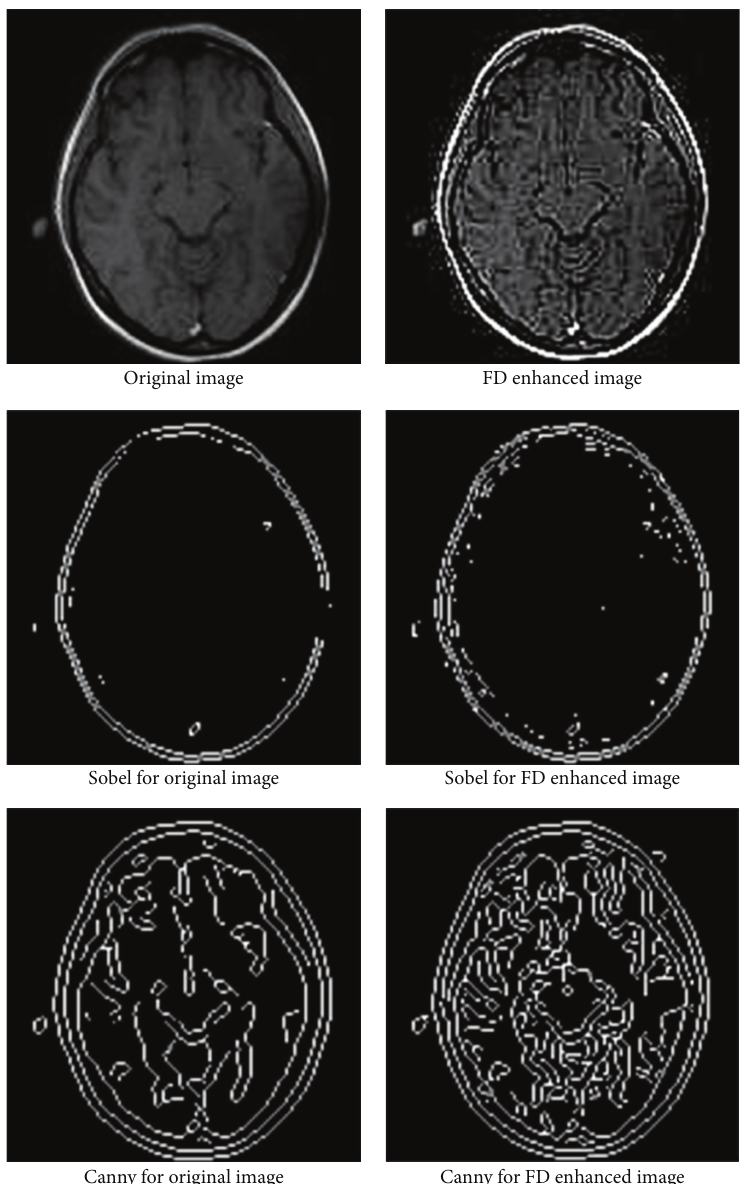
Figure 3: Results of the proposed enhancement algorithm by using FD masks for 𝜌 = 6 , 𝜇 = 0.05 , and 𝛼 = 0.5